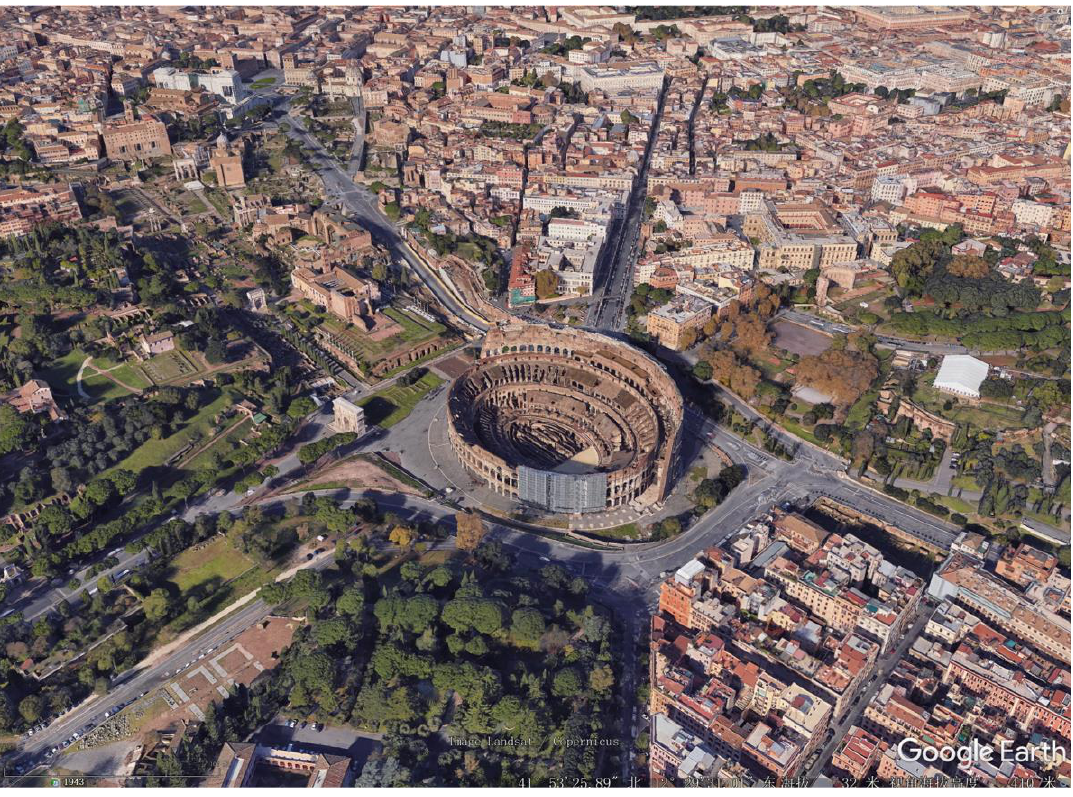
Figure 10. A sky-view 3D image of the Historic Centre of Rome (Roman Colosseum-centred view) for ACH virtual tourism. Imagery © 2018 Digital Globe.